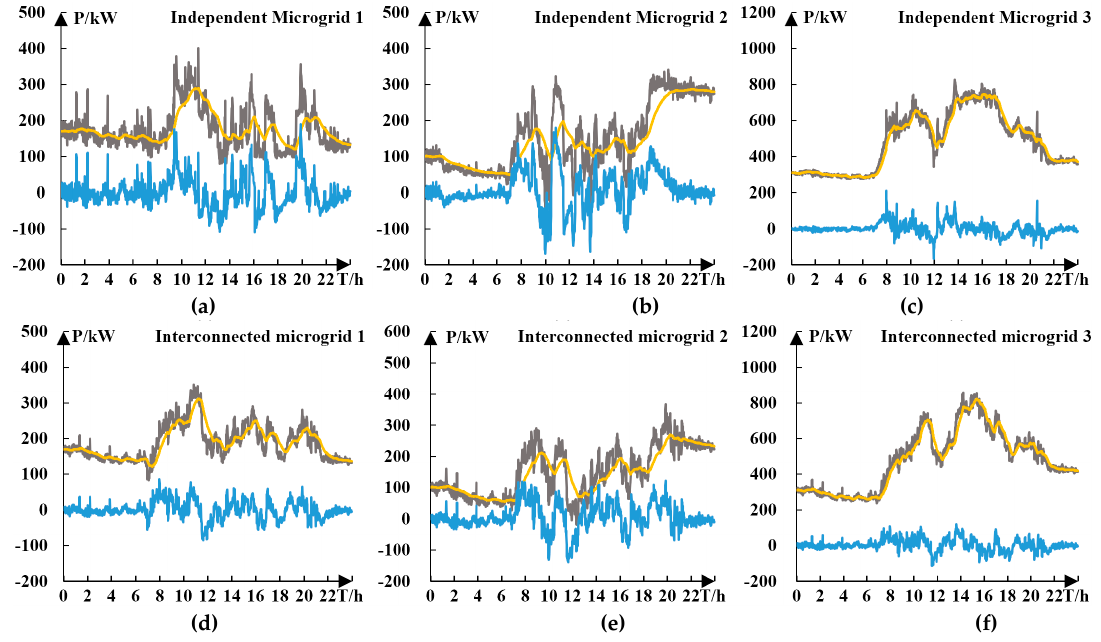
Table 5. ESS capacity of interconnected microgrid scheme with Objective 2.